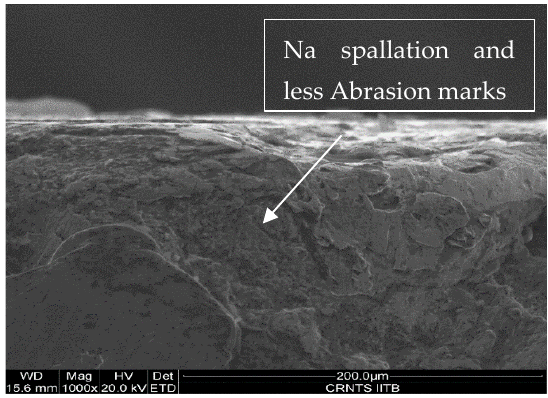
Figure 5. Flank wear of tool with optimized parameters.